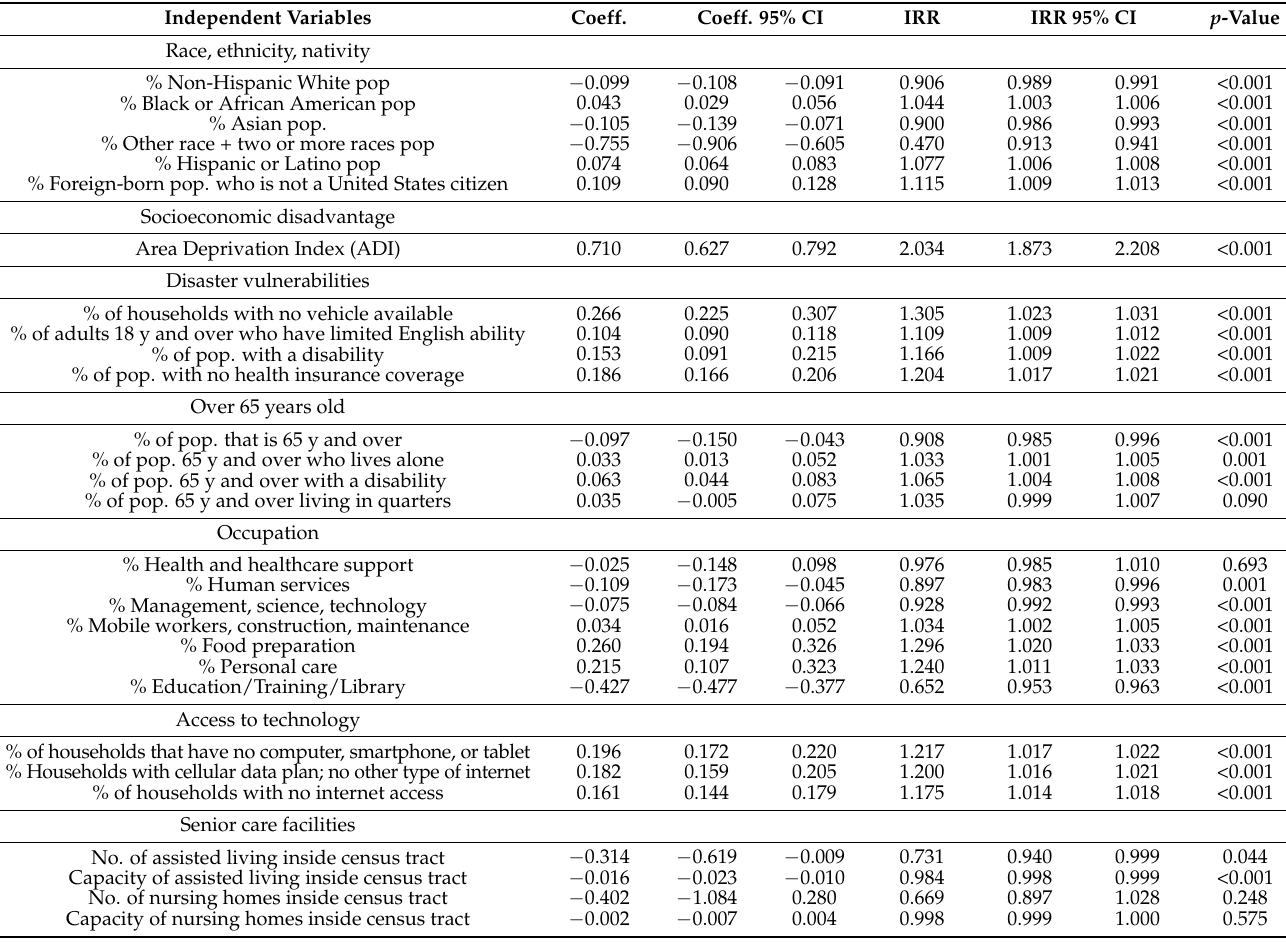
Table 2. Univariate model of neighborhood factors and the community incidence of COVID-19 in Harris County, Texas,